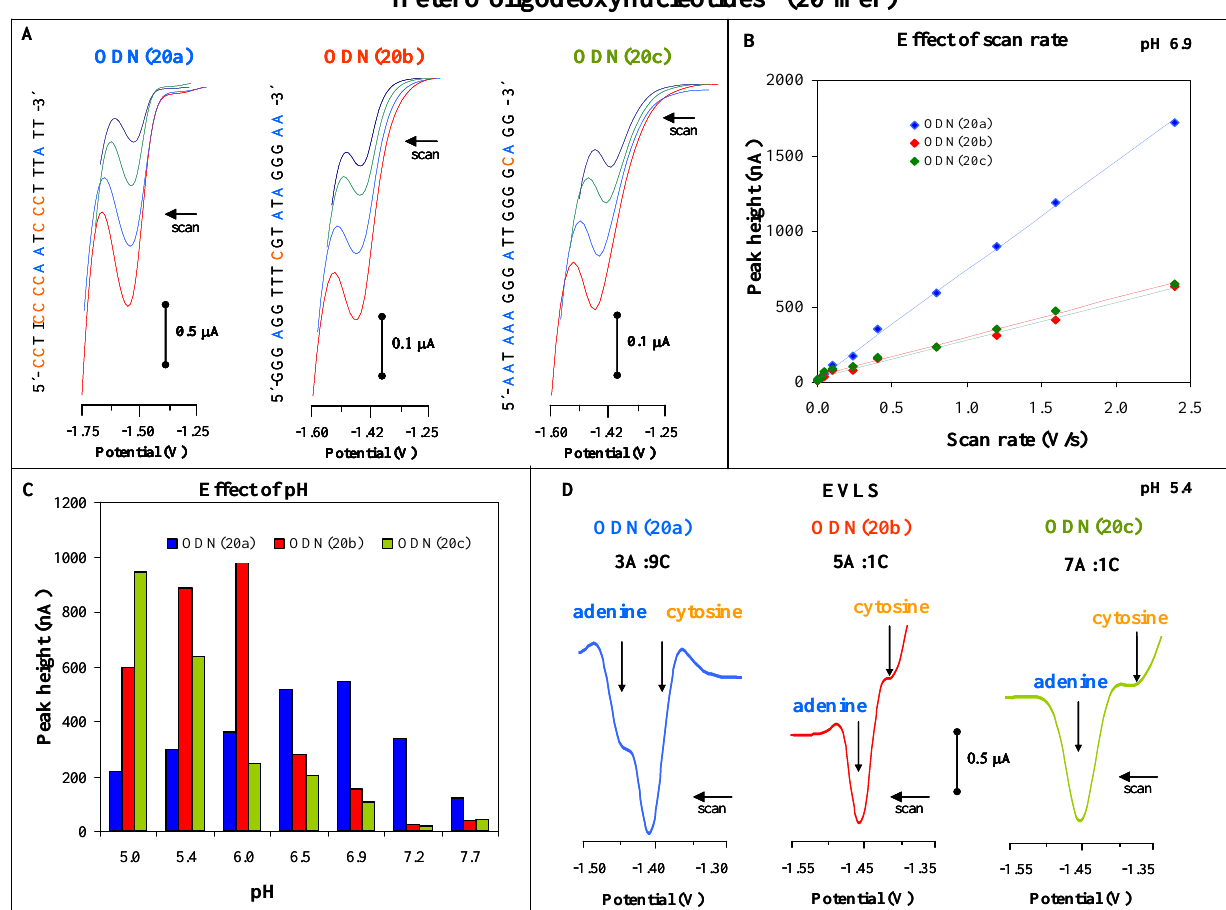
Figure 4. Analysis of hetero-oligodeoxynucleotides (20-mers): ODN(20a), ODN(20b), and ODN(20c) with the A:C ratio the in primary structure of ODNs of 3:9, 5:1, and 7:1, respectively. A ) Voltammograms of ODNs (1 µ M) in the presence of 0.3 M ammonium formate and 0.05 M phosphate buffer (pH 6.9) at different scan rates (200, 400, 800 and 1 600 mV/s). B ) Dependence of ODNs current responses on scan rate. C ) Influence of pH (0.1 M phosphate buffer) on the height of ODNs signals. D ) Elimination voltammograms of ODNs suitable for the function eliminating kinetic and charging currents, and conserving the diffusion current (reference scan rate of 800 mV/s, pH 5.4). For other details see Fig.